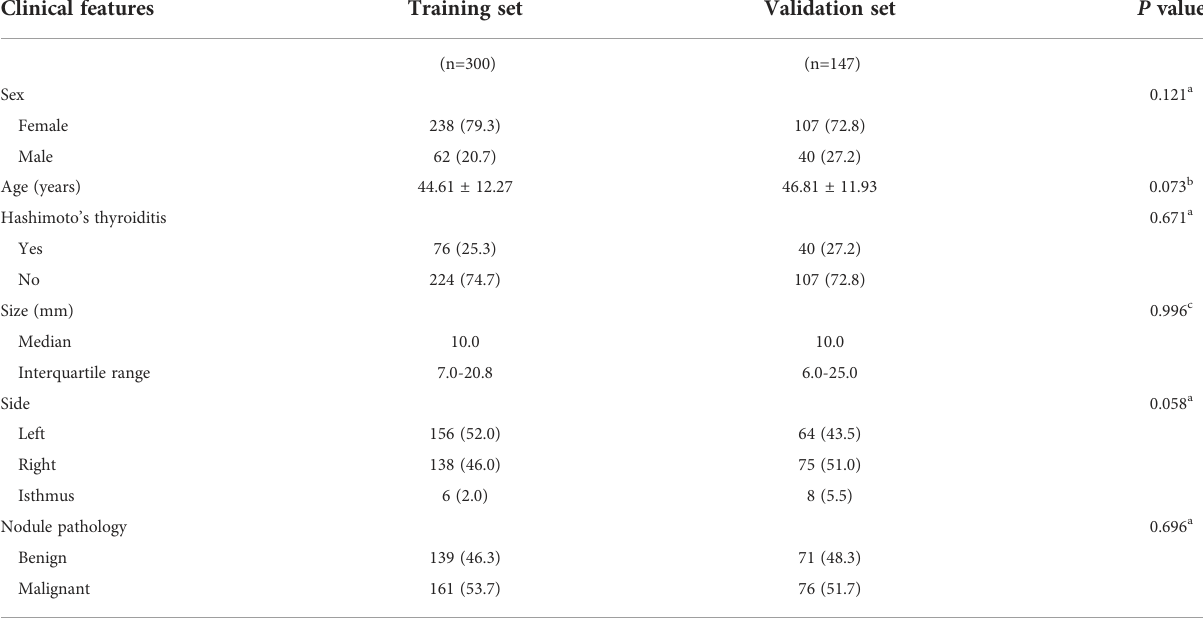
TABLE 1 Clinical features of benign and malignant thyroid nodules. Clinical